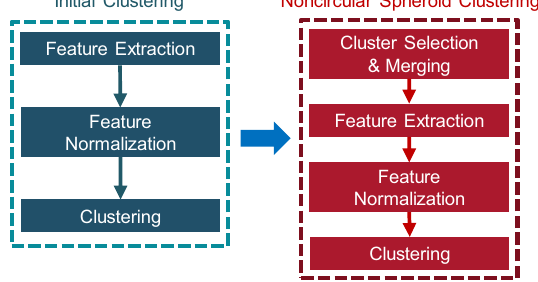
Figure 1. Overview of the HETEROID framework. VSMC spheroid images ( A ) were segmented by VGG16- U-Net semantic segmentation ( B ), and feature vectors were extracted for additional clustering analyses. A two-level clustering framework ( C ) was used to analyze the presence of morphological subpopulations of VSMC spheroids. Initial clustering analysis was focused on the roundness of the spheroids. Subsequent clustering analysis was focused on disrupted